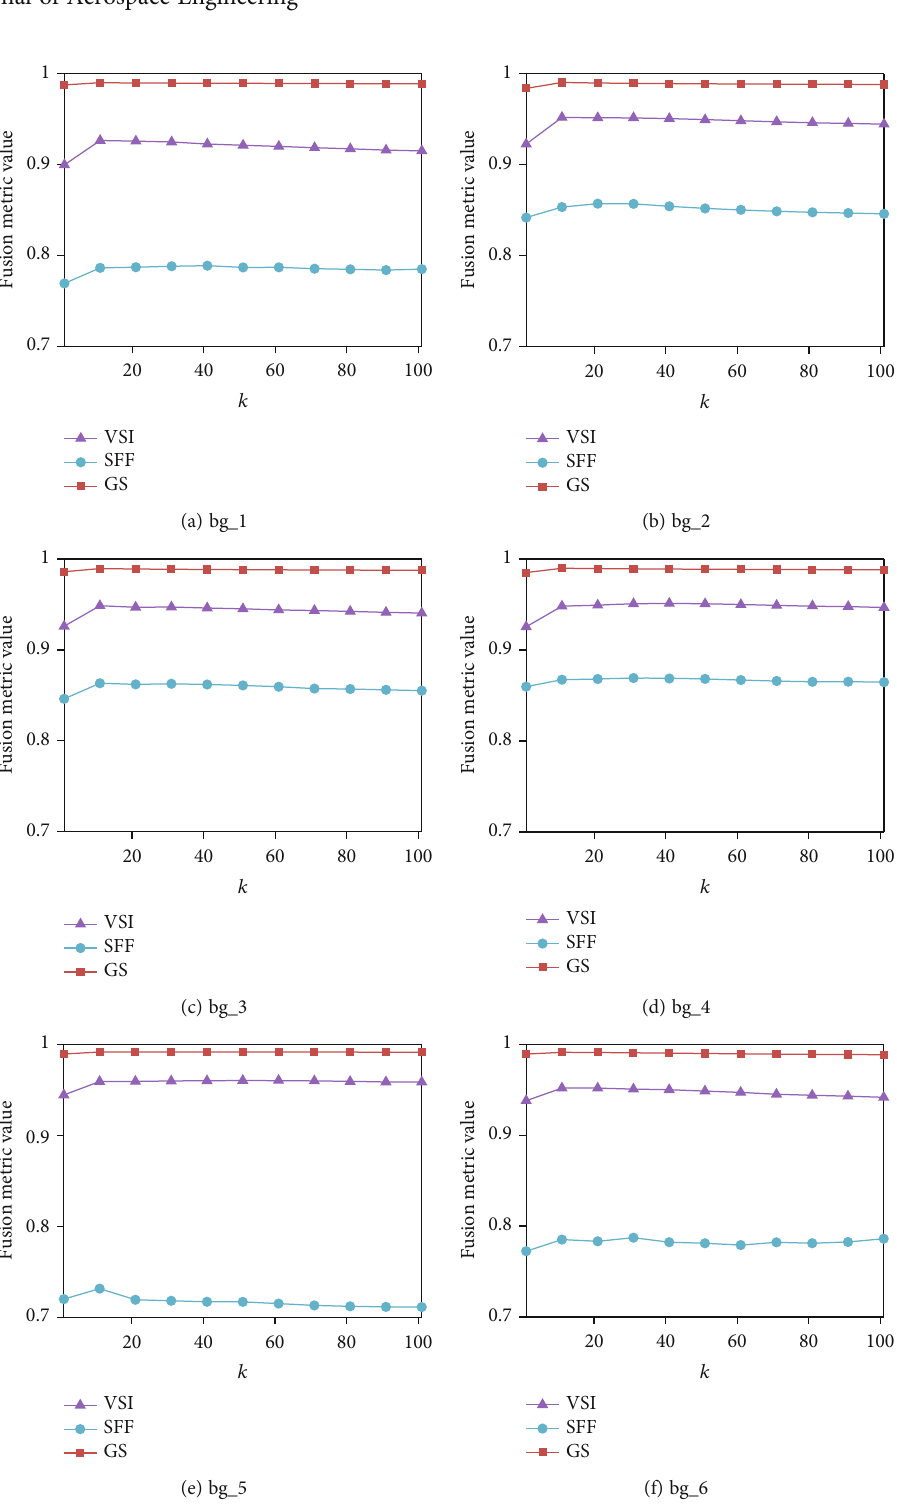
Figure 4: Performance of the proposed method with di ff erent settings of parameter k for di ff erent